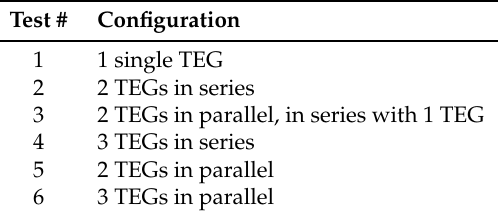
Table 1. Tests performed with the